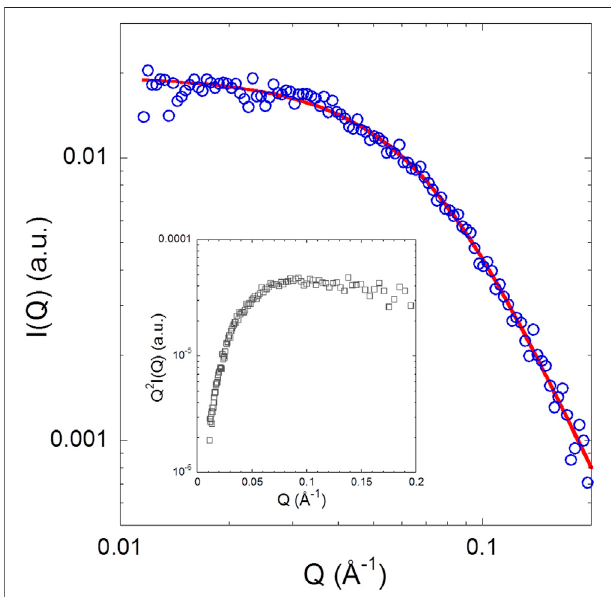
FIGURE4|SAXSpatternofNUPR1 :Thesolidlinerepresentsa fi twith ageneralizedGaussiancoilwith R g (cid:2) 2.5 nmand v (cid:2) 0.36 ± 0.01.Inset:Kratky plot of the experimental